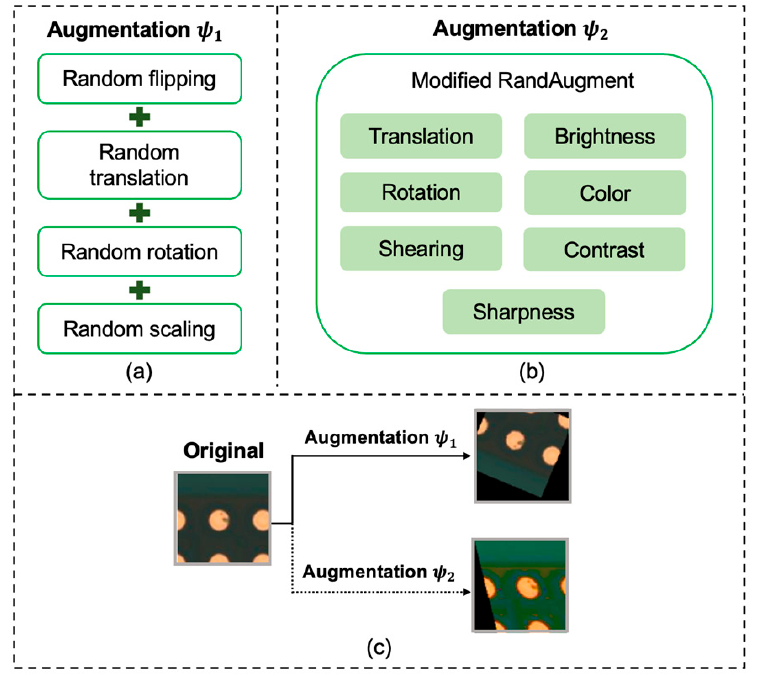
Figure 2. Augmentation process used in this study: ( a ) augmentation for labeled data and unlabeled data for pseudo prediction ( ψ 1 ), ( b ) augmentation for unlabeled data ( ψ 2 ), and ( c ) examples of images augmented by the two types. Table 3. List of transformations and their ranges.